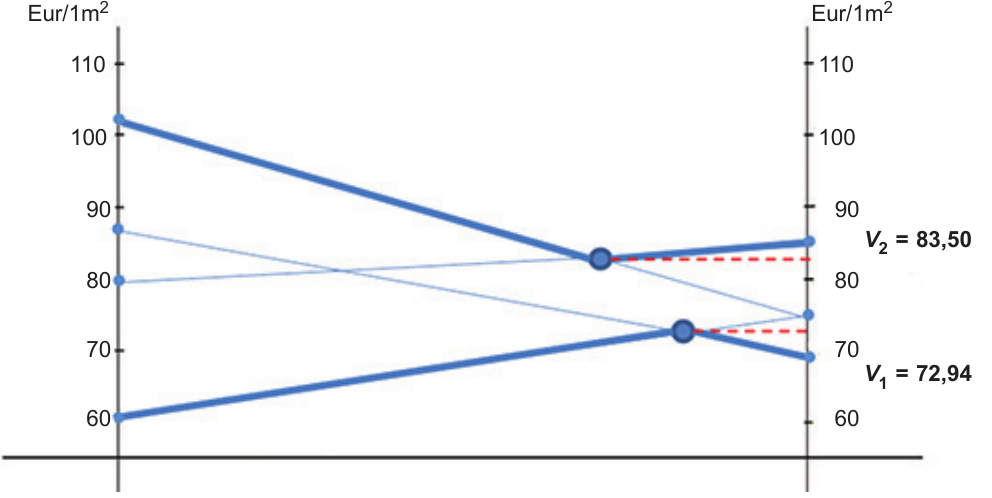
Figure 4. a graphic interpretation of the interval of property